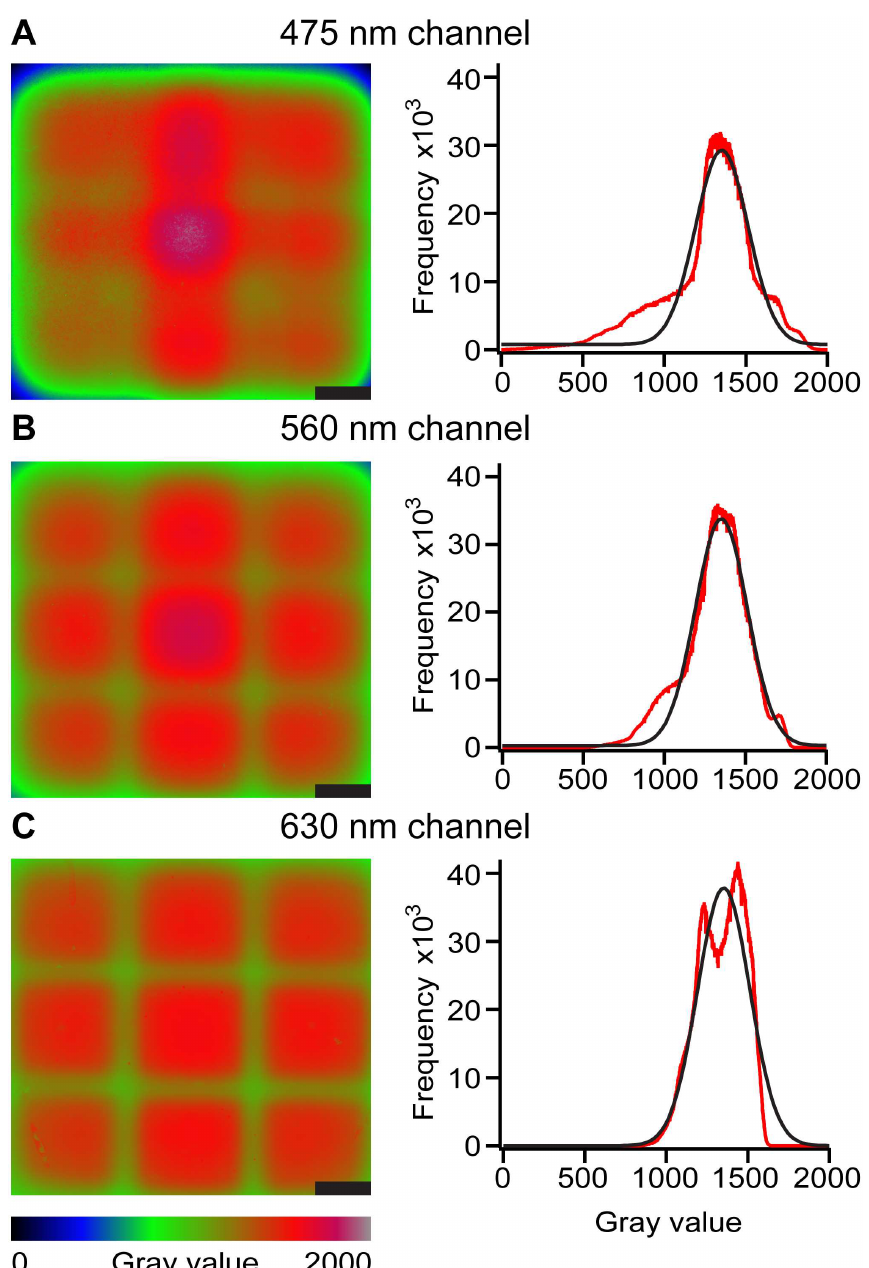
Fig 4. Results of the optical characterization of the real-time digital nucleic acid amplification instrument. Heat maps (left) and histograms (right) of custom fluorescence standardsshow the uniformity of illumination over the field of view as quantifiedin each of three fluorescent channels. Results from each channel were scaled to equalize each channel’saverage gray value. The gray values from the heat maps and histograms are truncated to between 0 and 2000 as reported by the instrument’s built-in camera at each channel: (A) 475 nm, (B) 560 nm, and (C) 630 nm. Scale bars are 10